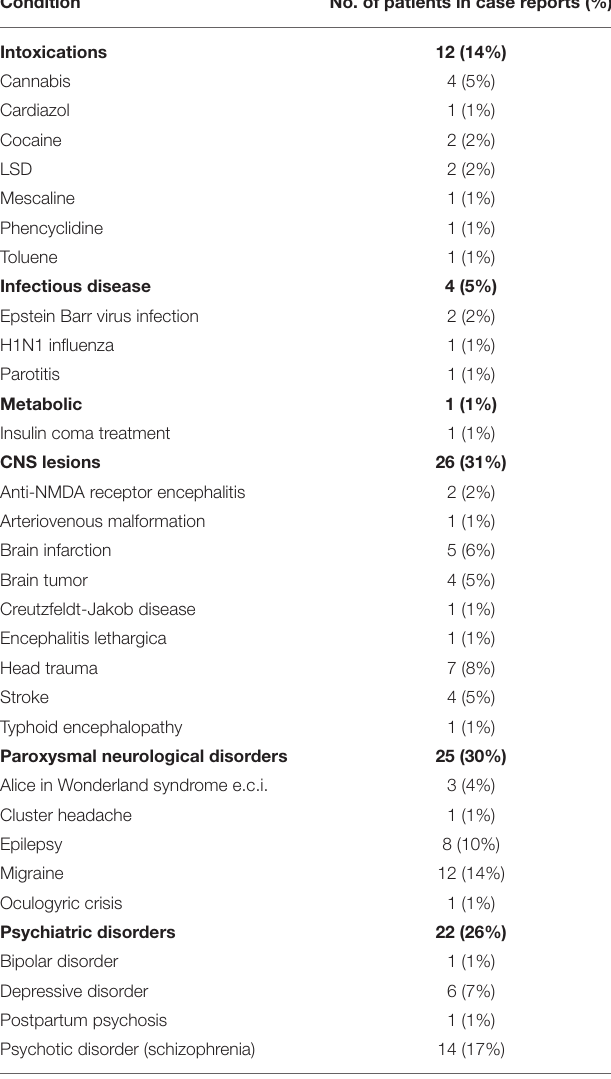
TABLE 2 | Conditions in the context of which time distortions are described in the literature, with numbers of patients mentioned in individual case descriptions ( N =